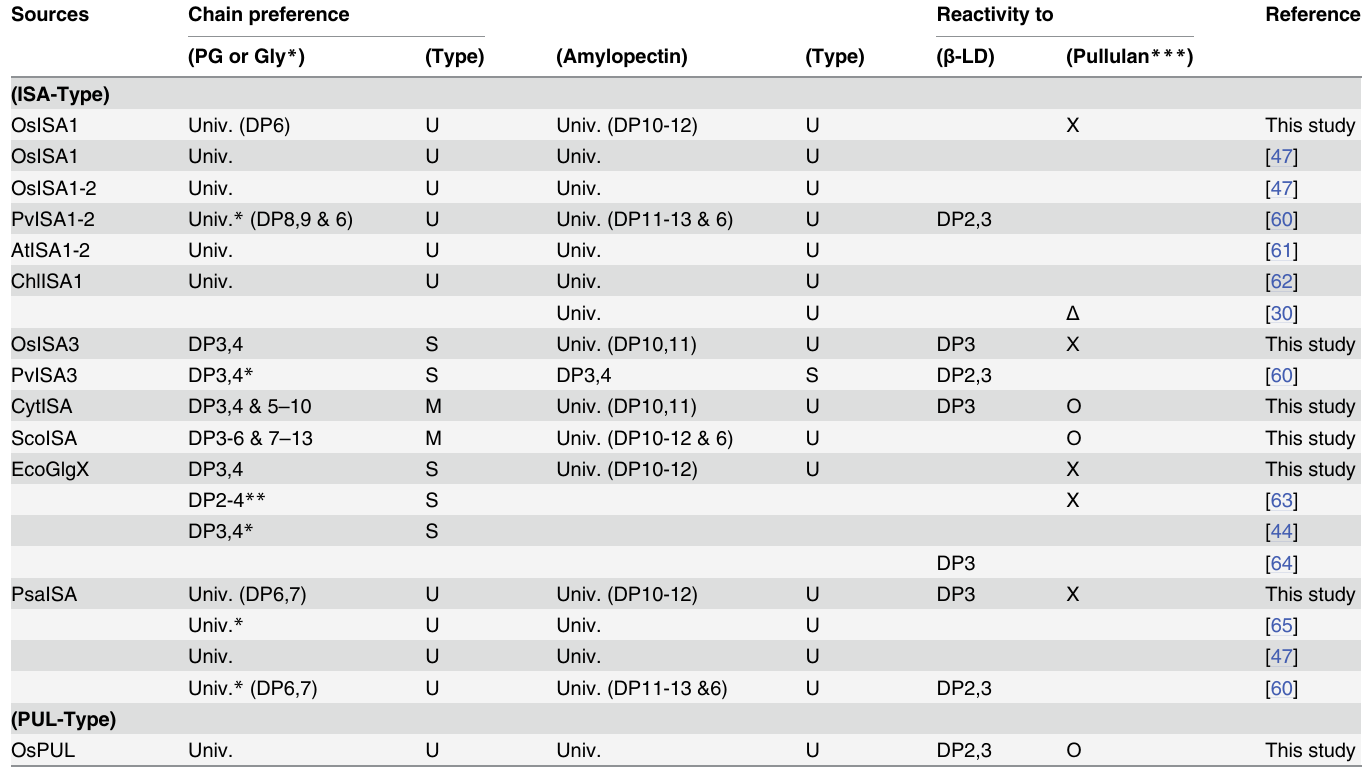
Table 2. Chain-length specificities of ISA-type DBEs from various sources.